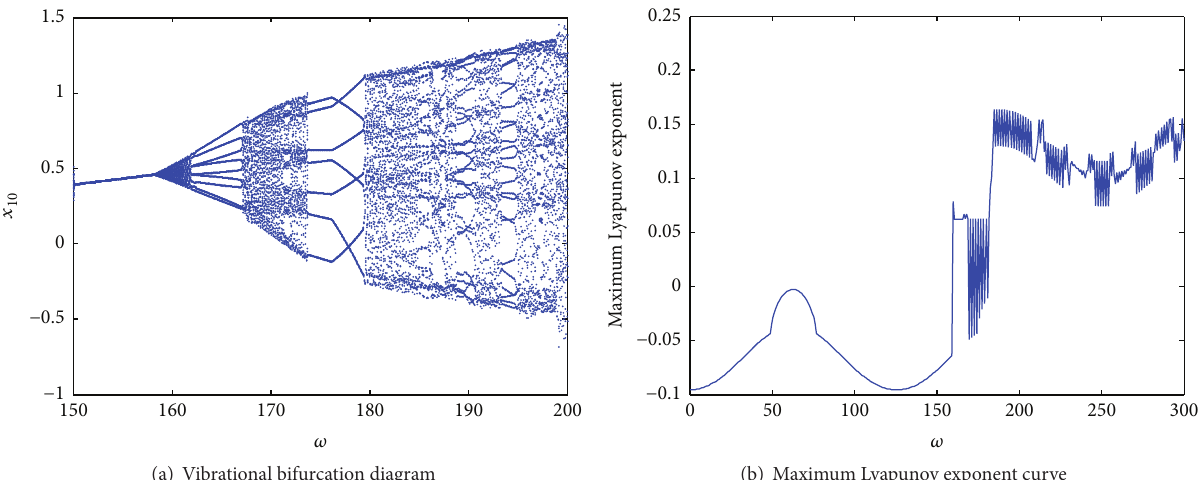
Figure 3: System response without random perturbation.